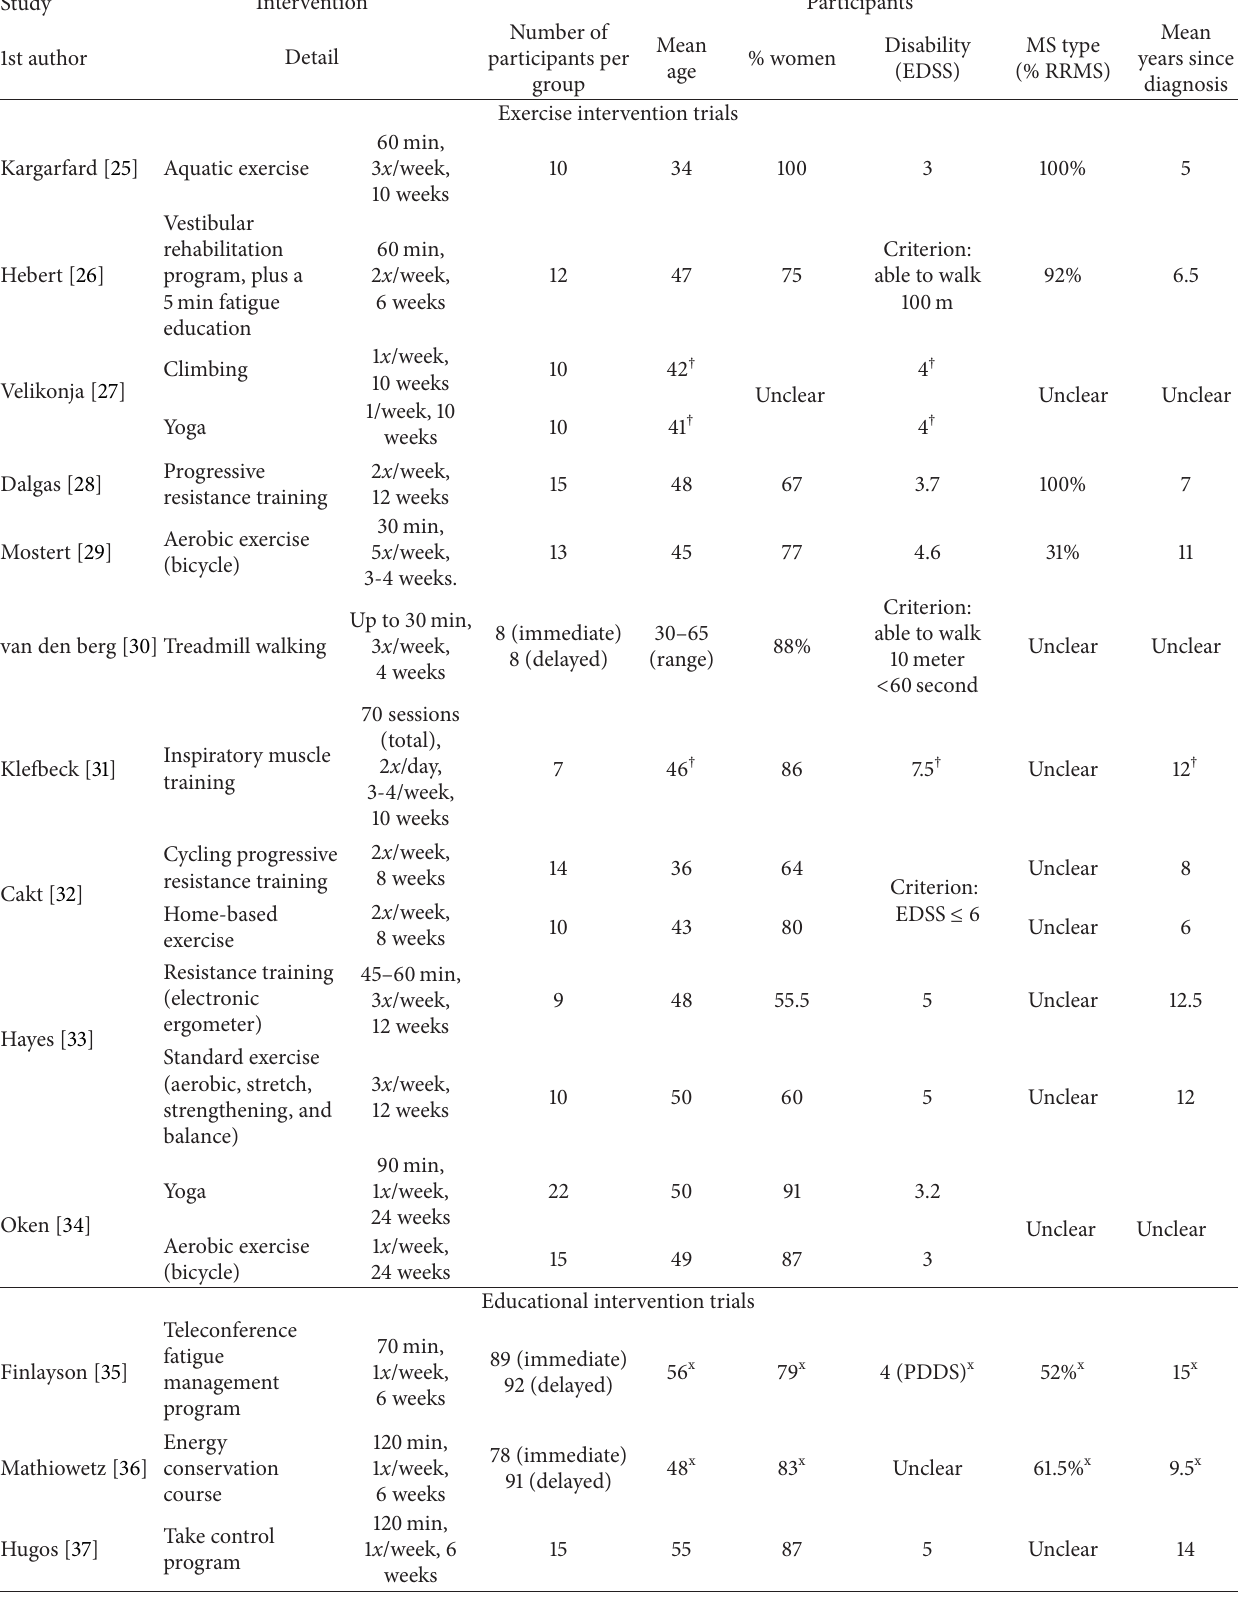
Table 3: Table of active interventions and their participants of the trials included in the